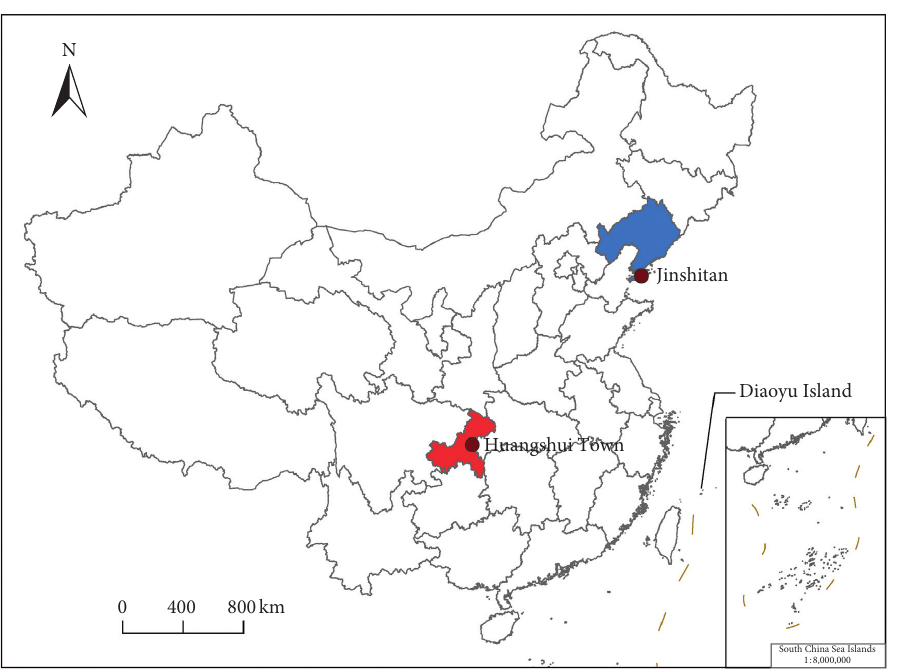
Figure 1: The location of the study